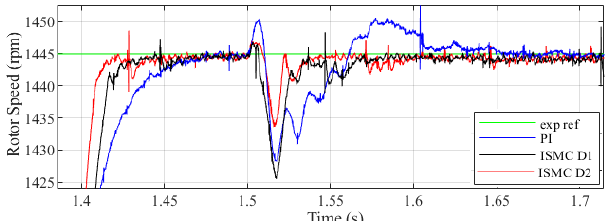
Figure 6. Experimental tests for performance comparison between the D1, D2 and the PI regulators by using 1445 rpm reference